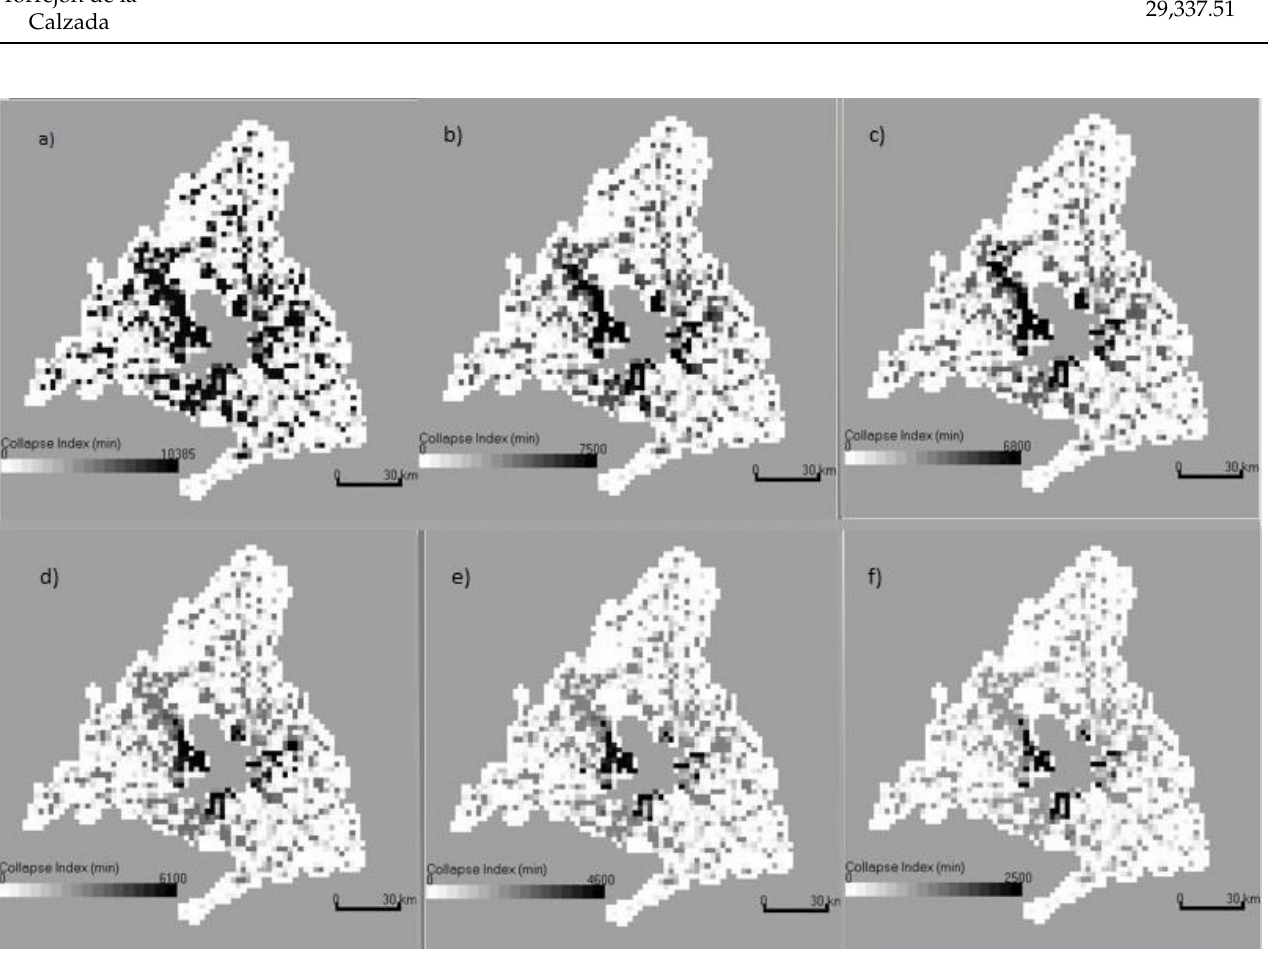
Figure 3. Collapse index maps: ( a ) only old FS; ( b ) old FS and 1 new FS; ( c ) old FS and 2 new FS; ( d ) old FS and 3 new FS; ( e ) old FS and 4 new FS; ( f ) old FS and 5 new FS. The fire stations with the highest workload are Navacerrada and Alcalá. The result of all the optimisation processes is that one station should be in the municipality of La